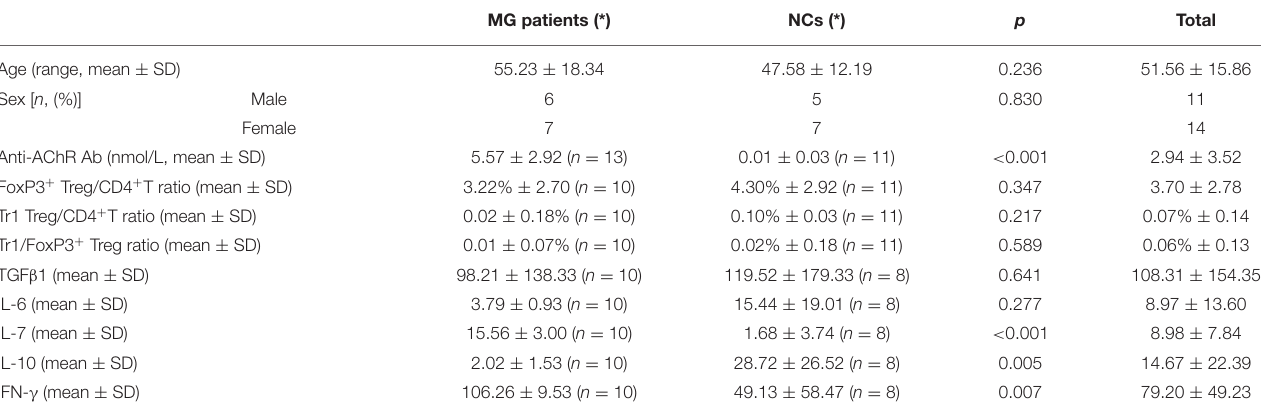
TABLE 1 | The basic clinical characteristics of the subjects enrolled in this